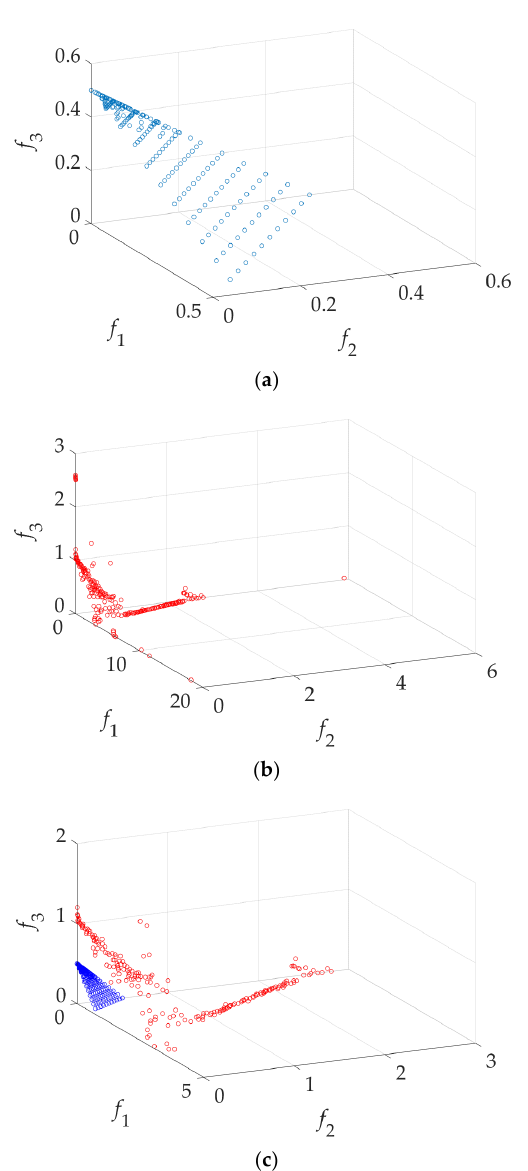
Figure 8. Approximate Pareto fronts of DTLZ1 ( n = 6): ( a ) obtained by GSDP; ( b ) obtained by NSGA-II; ( c ) comparison between GSDP and NSGA-II.